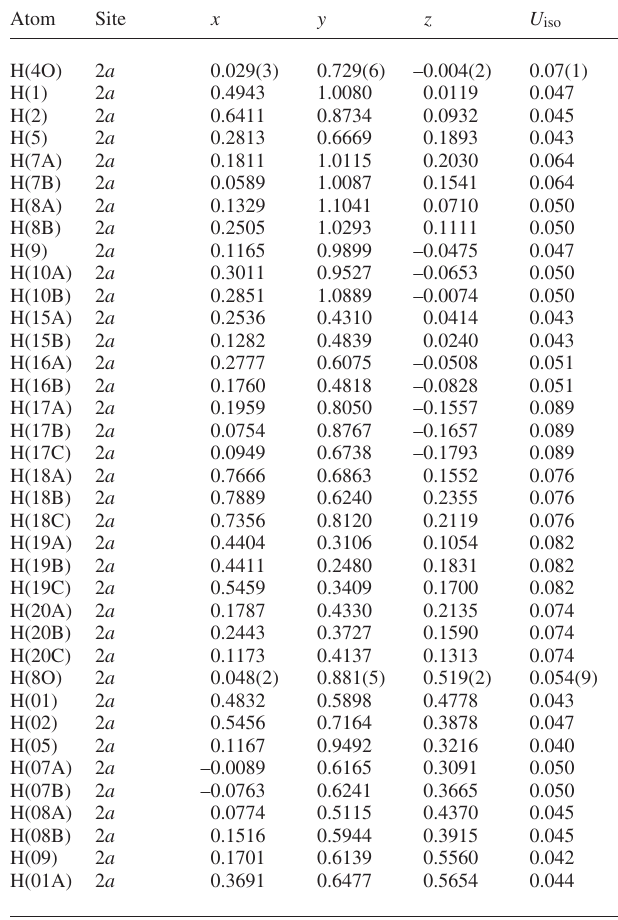
Table 2. Atomic coordinates and displacement parameters (in Å 2 )